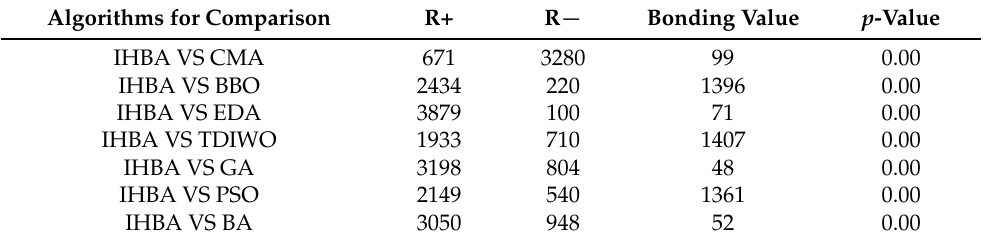
Table 9. The Wilcoxon paired signed test result at C = 40 and α = 0.05.